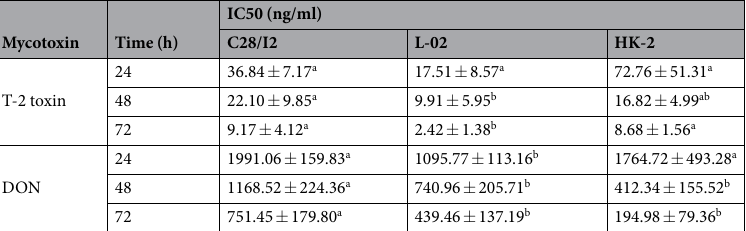
Table 1. The IC50 values for T-2 toxin and DON on C28/I2, L-02 and HK-2 cells. IC50 is the dose required to inhibit cell proliferation by 50%. Results are expressed as mean ± SD (n = 3). Data in the same exposure time marked with different letters means significant difference (p <